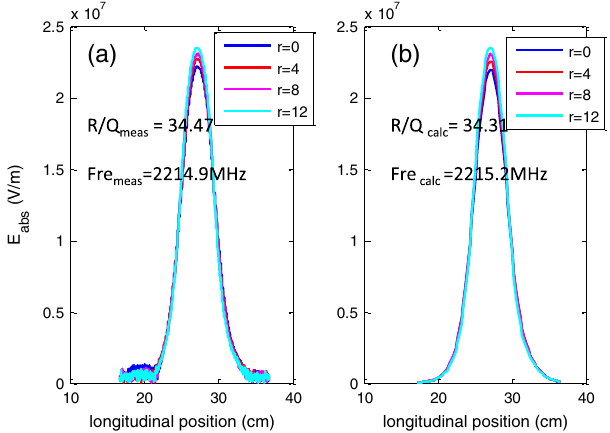
FIG. 19. The measured (a) and calculated (b) field distribution of the TM 010 -like mode with increasing horizontal offset (on-cell damper directions). The unit of r is millimeter.